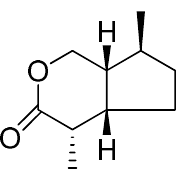
Figure 1. Basic structure of iridoids .